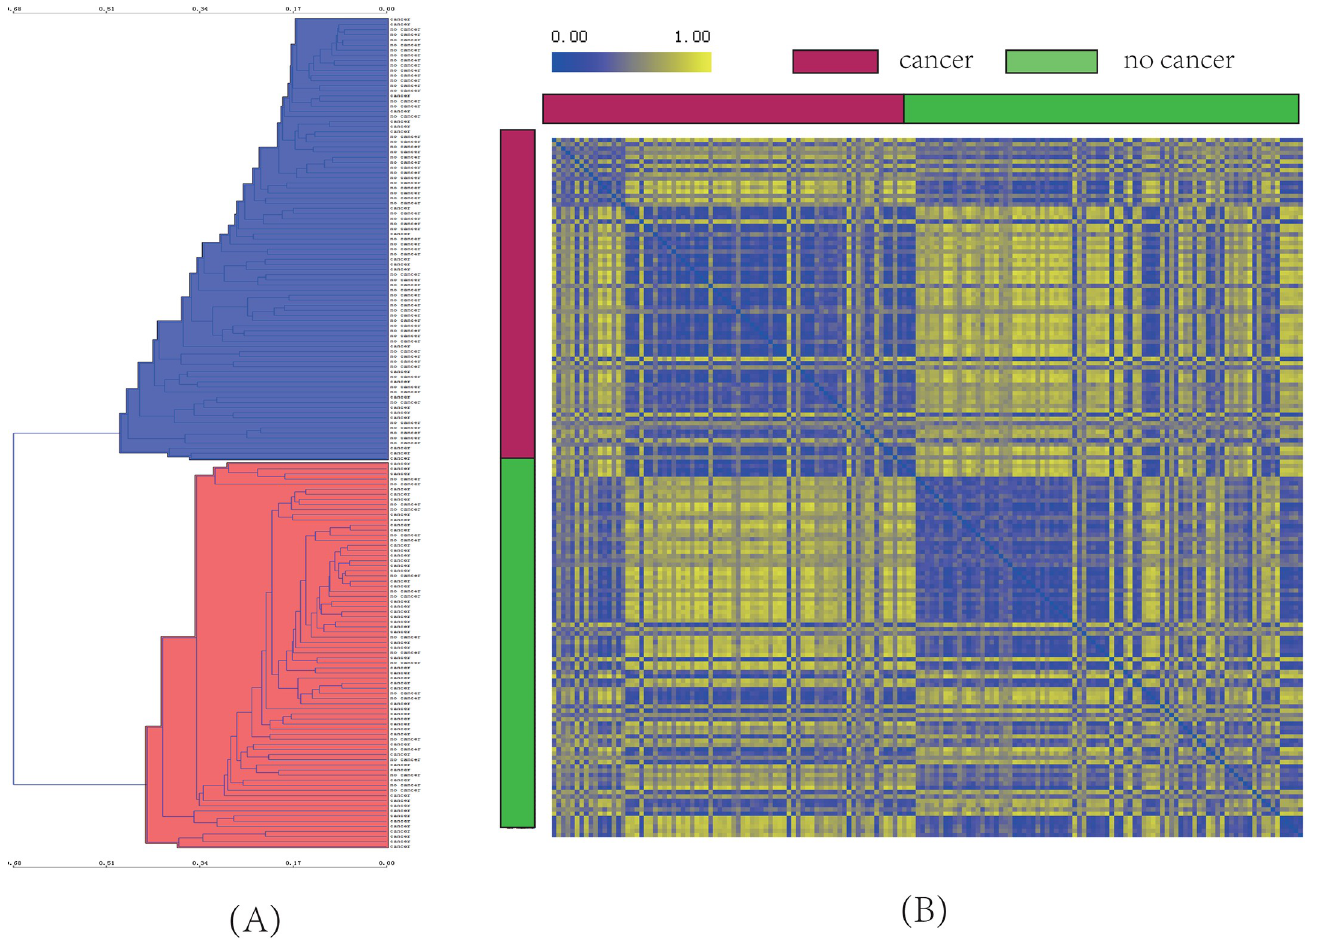
Fig 2. Clustering results of 163 smokers. (A) Unsupervised hierarchical clustering results, blue represents predomination of non-lung cancer, red represents domination of lung cancer; (B) Distance map of lung cancer samples and non-lung cancer samples. The closer the distance, the closer the color is to blue; the further the distance, the closer the color is to